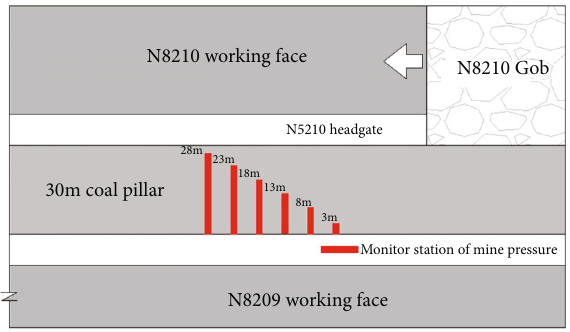
Figure 10: The layout of monitoring